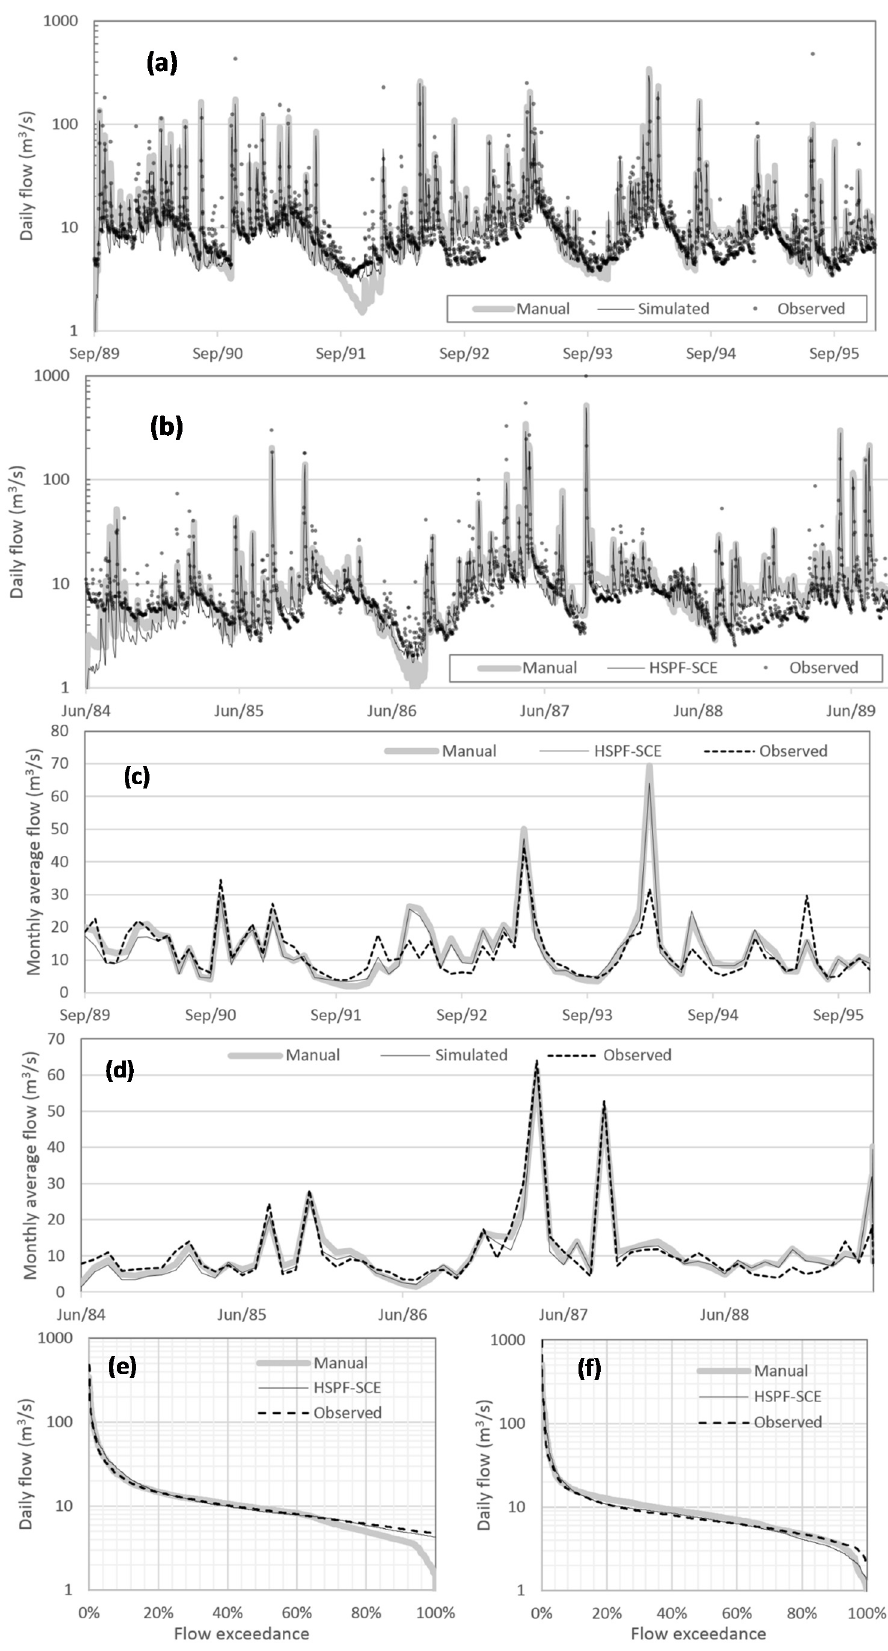
Figure 8. Comparison of the observed and simulated daily and monthly hydrographs with the selected parameter set for the Pigg River watershed. ( a , b ) daily hydrographs; ( c , d ) monthly hydrographs; and ( e , f ) flow duration curves of daily